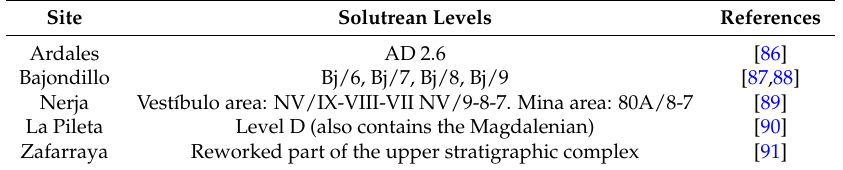
Table 3. Description of the Solutrean levels in the sample of sites. AD: Ardales, Bj: Bajondillo.